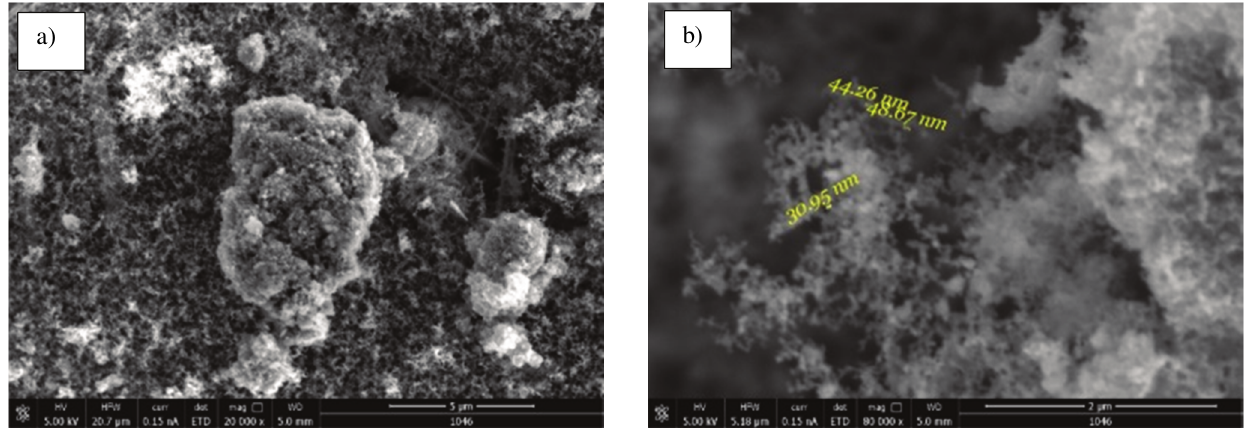
Fig. 3. SEM images of engine generated particles at different magnifications (a: 20 000 x; b: 80 000 x)